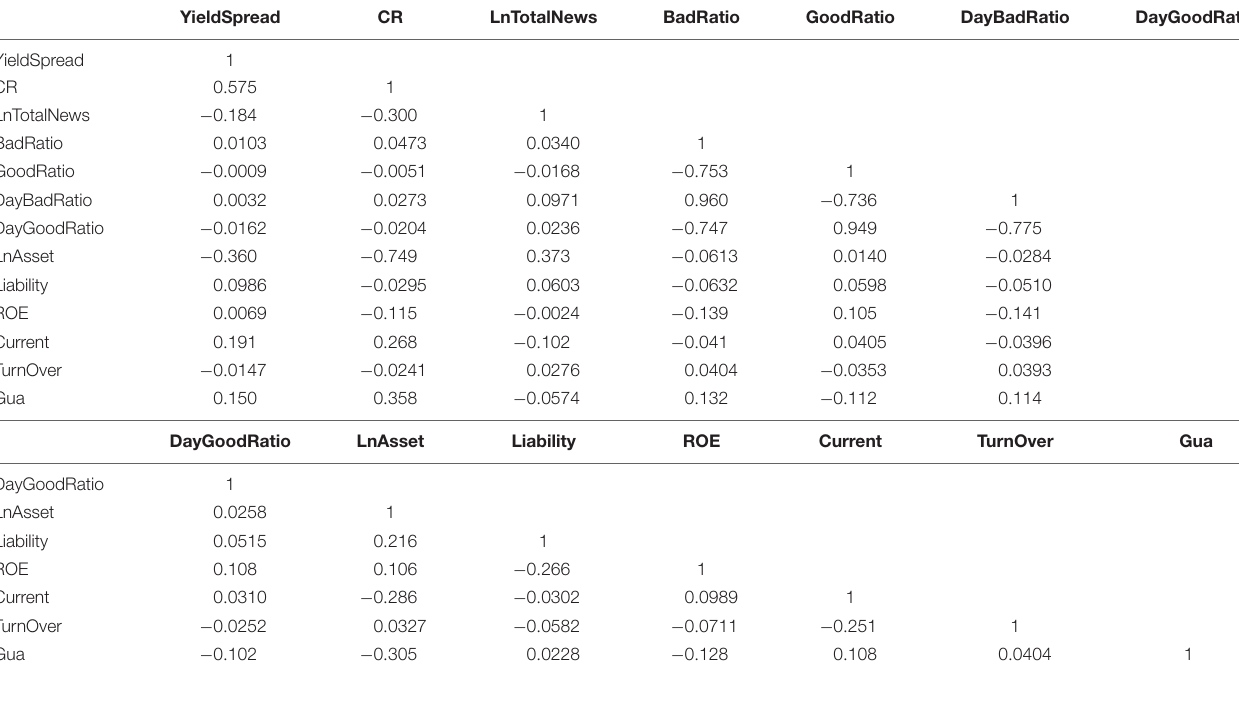
TABLE 3 | Pearson correlation